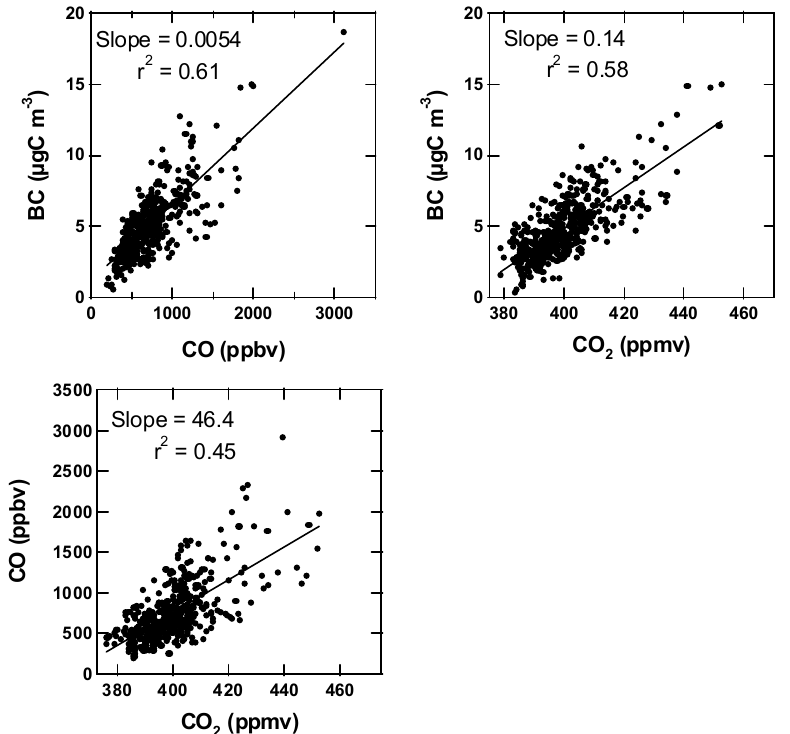
Fig. 8. Scatter plots of BC-CO, BC-CO 2 , and CO-CO 2 in all dataset measured during the campaign.